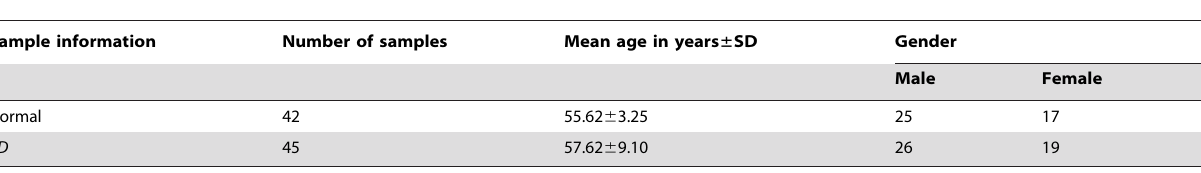
Table 4. Statistics of research participant’s involved in study.